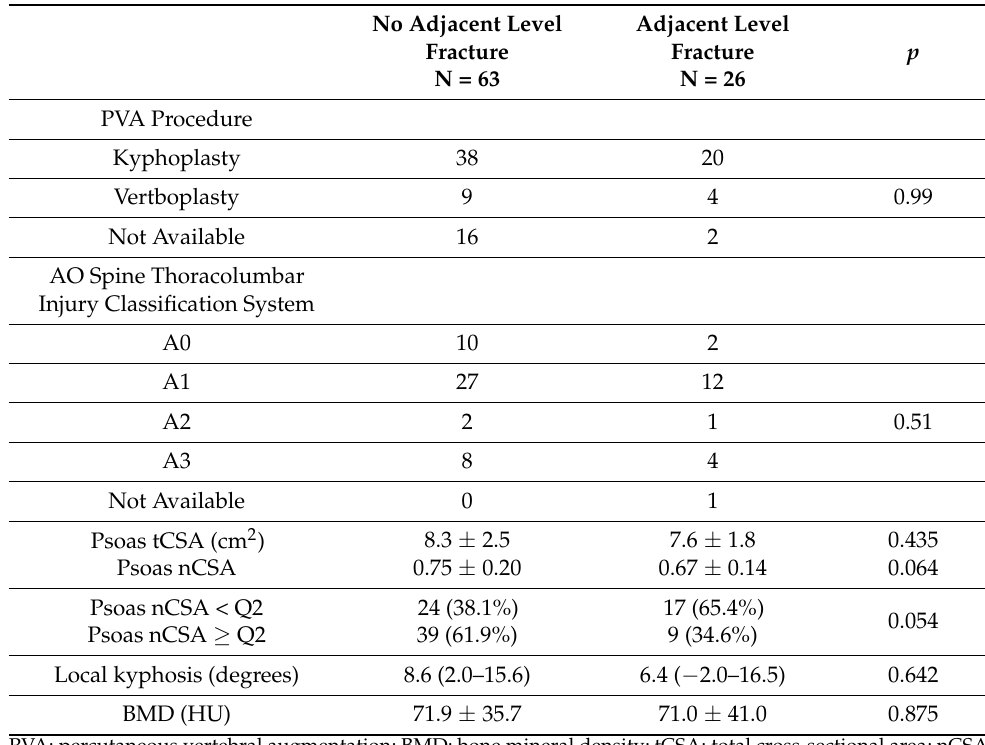
Table 2. Univariable analysis for associations between patient characteristics and adjacent level fracture.